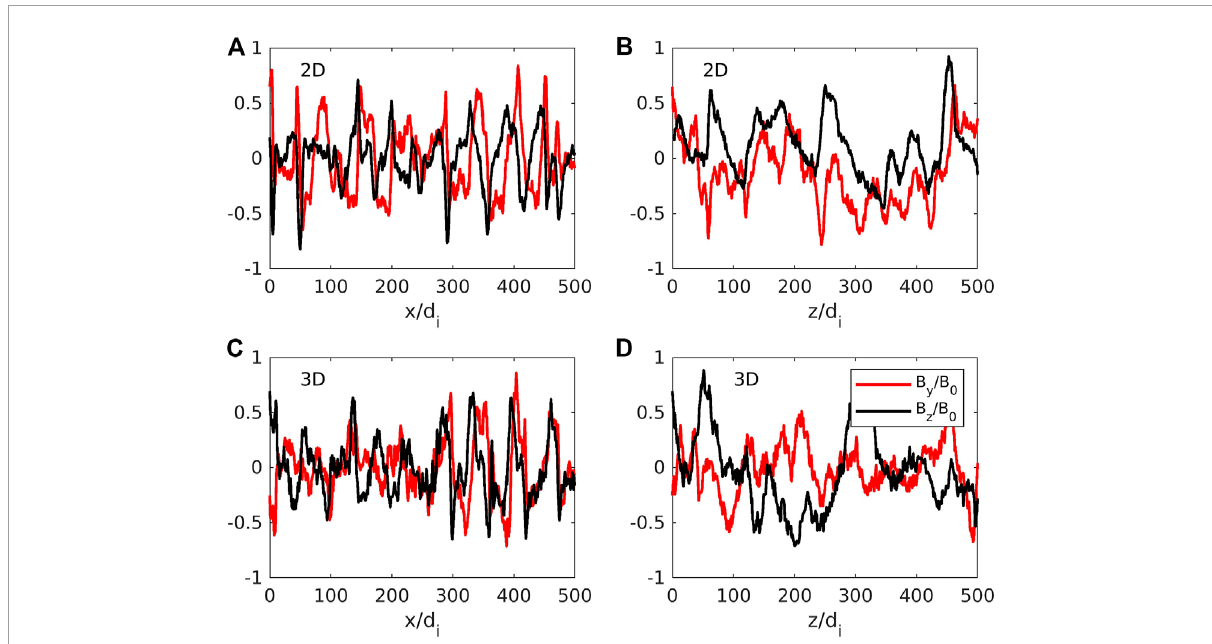
FIGURE 9 Comparison between (A, B) 2D and (C, D) 3D simulations. Left panels show B z magnetic field component and right panels show density fluctuations in runs with identical parameters ( n b / n 0 = . 02, M A = 10, β i = 1, β b = 4 . 5) at a late phase after the resonant mode has saturated. The 2D and 3D simulations have similar characteristic parallel and perpendicular length